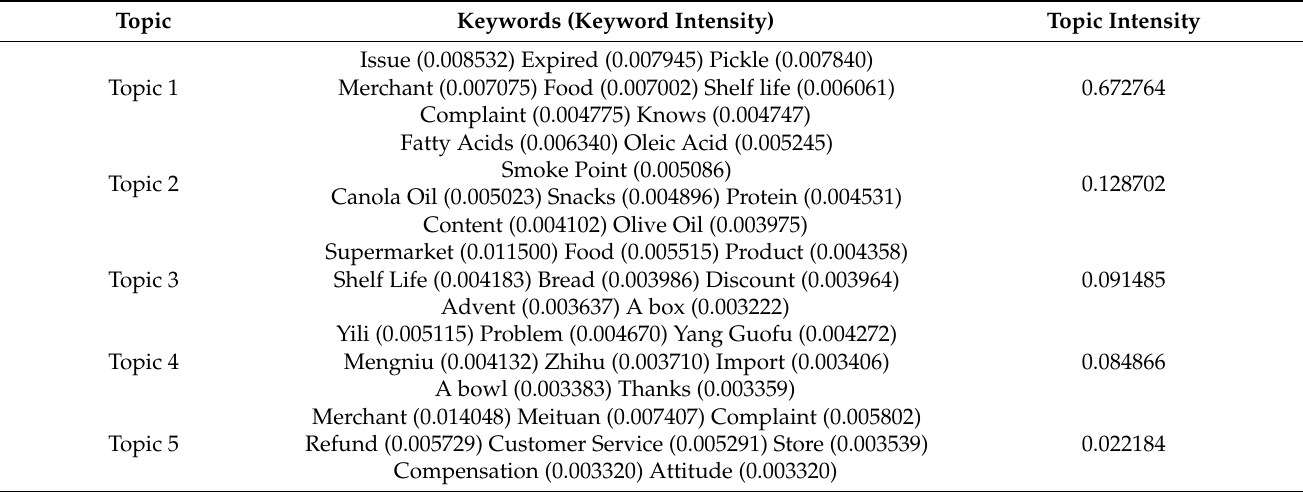
Figure 6. The perplexity of the BTM topic model. Table 9. Keyword distribution of BTM topic the intensity of each keyword.